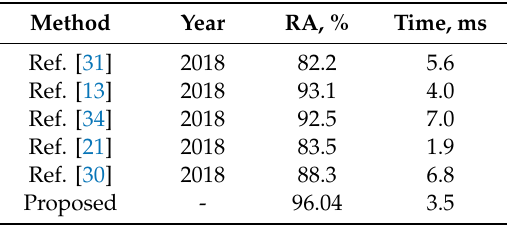
Table 6. Comparison with existing